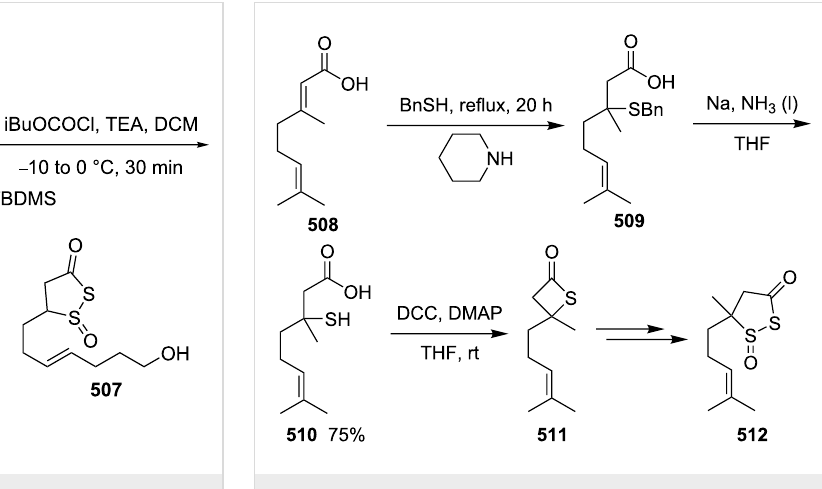
Scheme 118: Synthesis of 4,4-disubstituted thietan-2-one 511 via the intramolecular thioesterification of the 3-mercaptoalkanoic acid 510